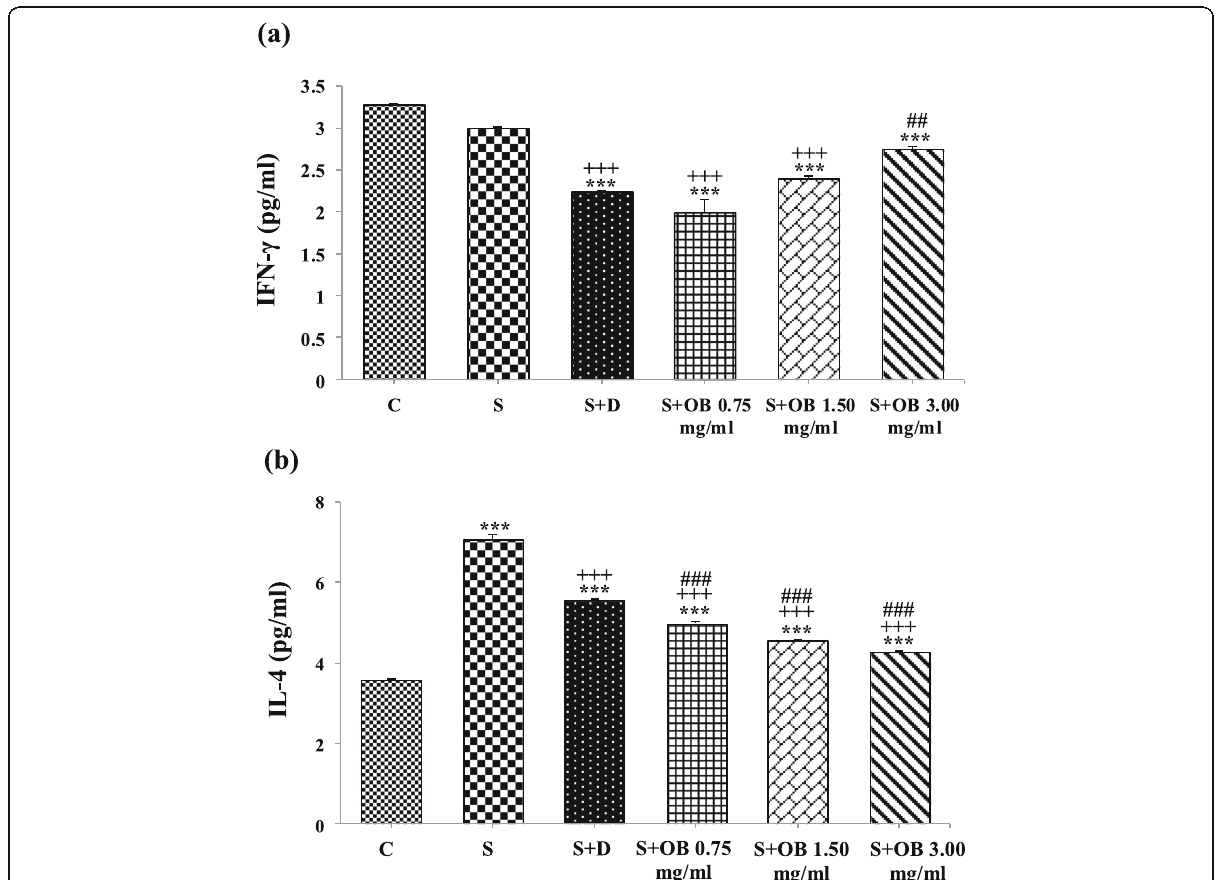
Fig. 2 Bronchoalveolar lavage fluid levels of IFN- γ ( a ) and IL-4 ( b ), (mean± SEM) in the control (C), sensitized (S), treated sensitized animals with dexamethasone (S + D) and three O. basilicum concentrations (S + OB) groups, (in each group, n = 8). ***: P < 0.001, comparison with C group. +++: P < 0.001, comparison with S group. ##: P < 0. 01, ###: p < 0.001, comparison with S + D group. One-way analysis of variance (ANOVA)